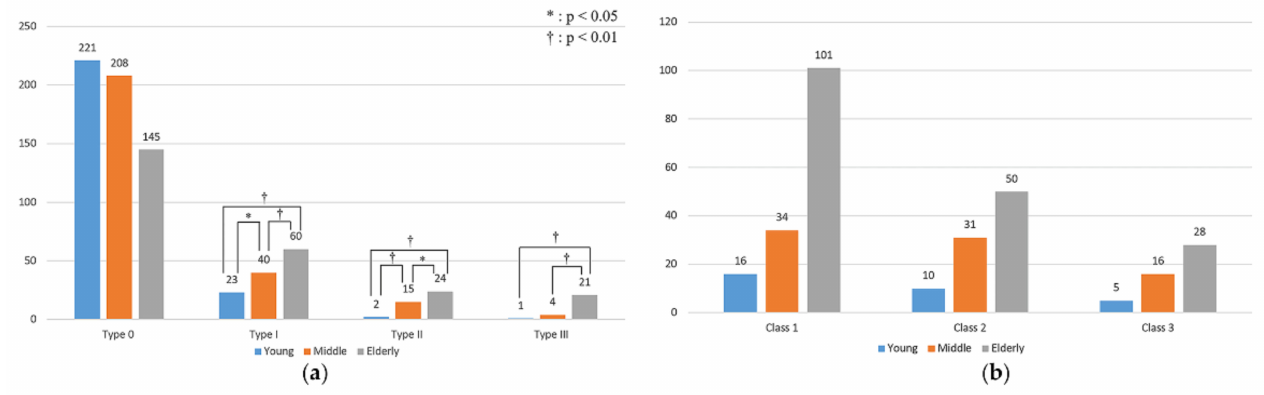
Figure 4. The distribution of different tooth types and tooth classifications among the three groups. ( a ) Tooth type distribution. The value of the ordinate indicates the number of cracked teeth. ( b ) Enamel crack classification distribution. The value of the ordinate indicates the number of different classes of